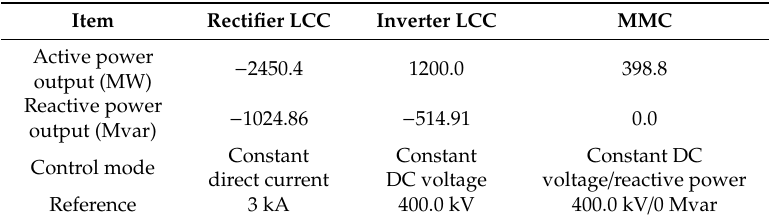
Table 2. The parameters of a decentralized hybrid HVDC system in a 39-bus system.